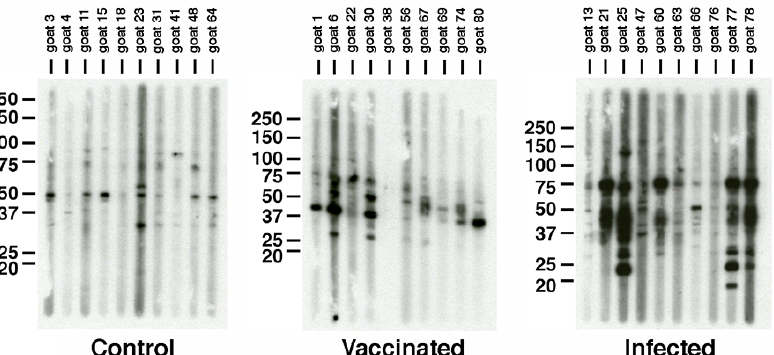
Figure 5. SDS-PAGE and strip immunoblot analysis of Map whole cell lysates. Preparative SDS-PAGE gels containing Map sonicated extract were immunoblotted. The blot was placed in a slot blot device and loaded with sera from each goat assigned to the three treatment groups. Note the variable antibody responses of each goat within the same treatment. Kilodalton size standards are indicated in the left margin and treatment is indicated beneath each immunoblot. All ten animals within each treatment were analyzed. 3.3.1. Map-Phage Expression Library Screen to Identify Reactive Antigens To identify Map antigens detected in each group, a Map -lambda phage expression library was differentially screened with antisera from the two treatment groups. Duplicate nitrocellulose plaque lifts were produced to screen approximately 80,000 library clones. One nitrocellulose lift from each plate was probed with pooled sera from vaccinated goats and the other lift was exposed to pooled sera from infected goats. Over 100 positive plaques were detected by the infected goat sera, and among these, 39 plaques were de- tected by sera from both groups. Nine of these plaques reacting with sera from both in- fected and vaccinated goats were randomly selected for purification, subcloning and se- quencing. Only 11 plaques were detected solely by sera from vaccinated goats and these were also plaque purified and sequenced. Analysis of these 20 positive phage clones showed an average insert size of 2.7 kb with the same genomic regions present in multiple clones (Supplemental Table S1). SDS-PAGE and immunoblot analysis of E. coli cultures harboring these 20 mycobacterial subclones showed that each produced a protein that was recognized by pooled sera from the vaccinated goats (Figure 6 and Supplemental Figure S3) or by goats from both groups (Supplemental Figures S4 and S5). The combined se- quence and immunoblot analysis revealed the identity of novel antigens, detected only by the vaccinated goats, encoded by MAP_0585, MAP_1561c, MAP_3185 and MAP_3420c (Figure 6 and Supplemental Figure S3). Conversely, well-known Map antigens were detected by sera from both infected and vaccinated goats. These include MAP_1569 (modD), which was identified in 7 of the 9 clones (Supplemental Figure S4). This gene encodes ModD, which has been identified as a strong antigen in cattle with Johne’s disease [17,18]. The other two clones contained MAP_1272c (Supplemental Figure S5), which has also been previously identified as a strong Map antigen [19]. A summary of the antigens detected in each library clone is shown in Table 2.